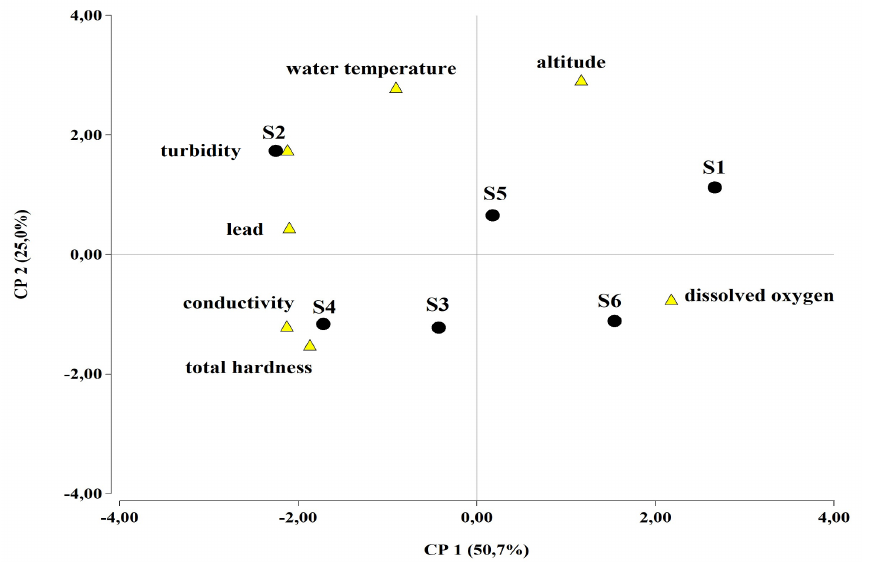
Figure 2. Spatial variability S1-S6 respect to: physical- chemical parameters and